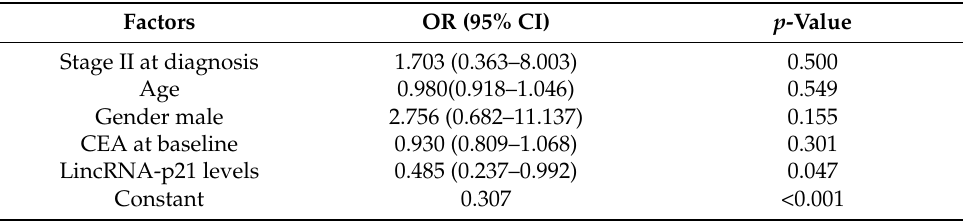
Table 2. Results obtained in the multivariate logistic analysis for complete response to neoadjuvant treatment (TRG4 vs. others).